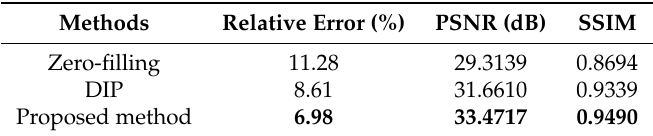
Figure 9. Comparison of the reconstruction results of the target MR image: ( a ) in Brain B at a 30% sampling rate under the radial undersampled mask with additive Gaussian noise; ( b ) zero-filling reconstruction; ( c ) DIP reconstruction; ( d ) the proposed method reconstruction and corresponding error maps ( e )–( g ). Table 5. Relative errors, PSNR, and SSIM values of reconstruction for Brain B by different methods at 30% sampling rates under the radial undersampled